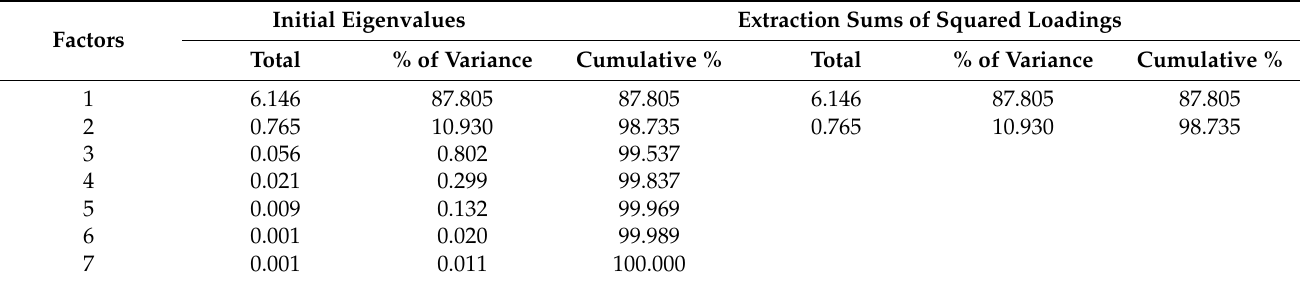
Table 6. Principal component analysis results of variables.